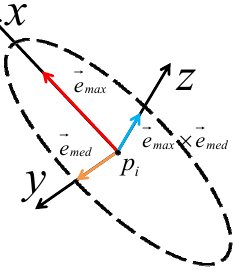
Figure 4. Local reference frame (LRF) of basis point.